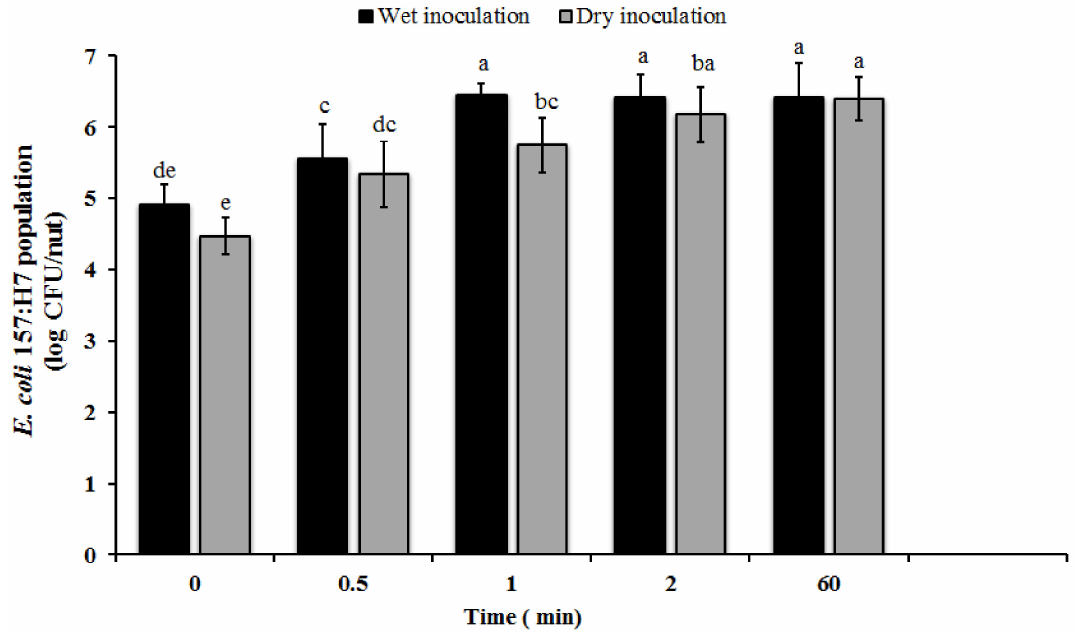
Figure 2. Attachment of E. coli O157:H7 on in-shell hazelnuts. In-shell hazel nuts were inoculated with approximately 7.7 log CFU of the pathogen/nut by dipping or using a sand carrier. Following inoculation, the nuts were sampled at 0, 0.5, 1, 2, and 60 min. The nuts were then washed to remove unattached bacteria and the adherent E. coli O157 population was enumerated. Data are represented as the mean ± SD. Bars with different superscripts are significantly different at p <